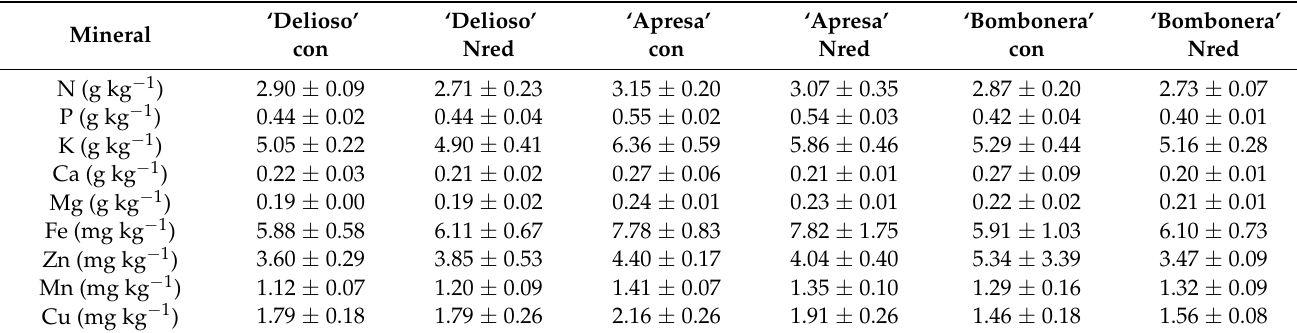
Table 4. Mineral composition of tomato fruits at harvest. The concentrations of the mineral elements are expressed on a fresh weight base. Mean of N = 4 ± SD. No significant differences between the con and the Nred treatment for the respective tomato varieties were observed ( t -test at α =